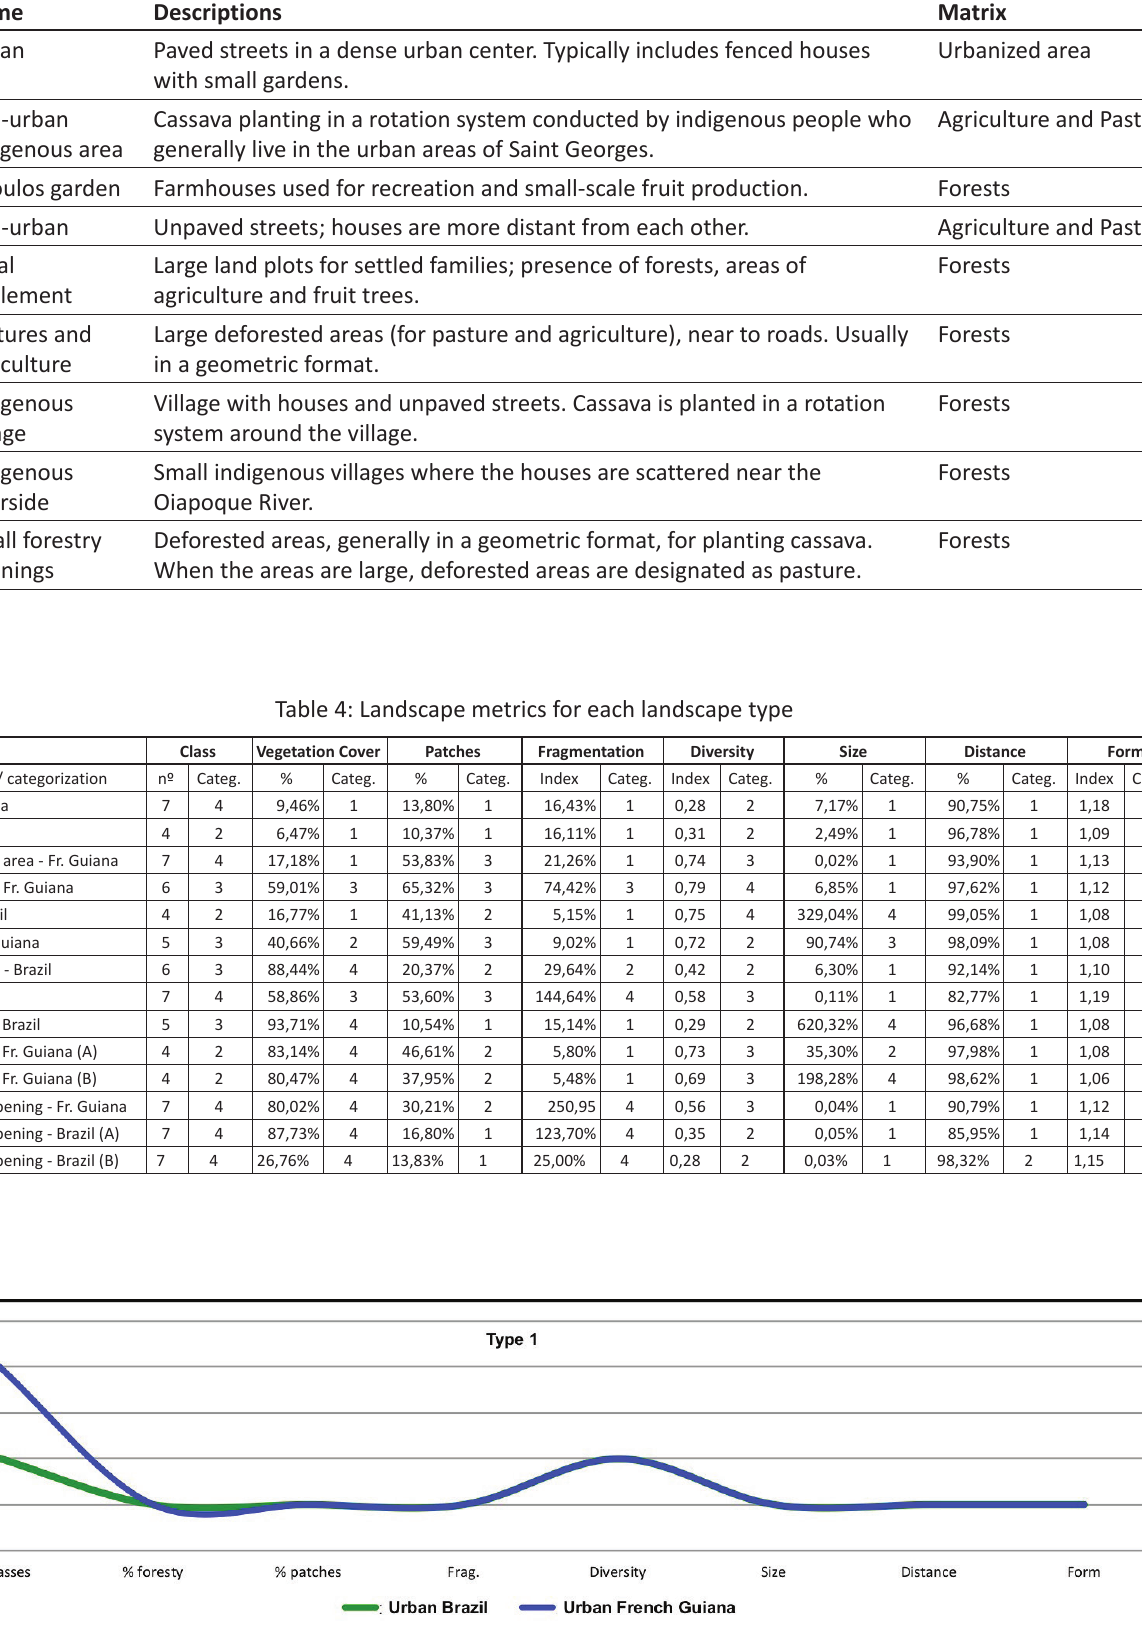
Figure 5. Signatures of the landscape